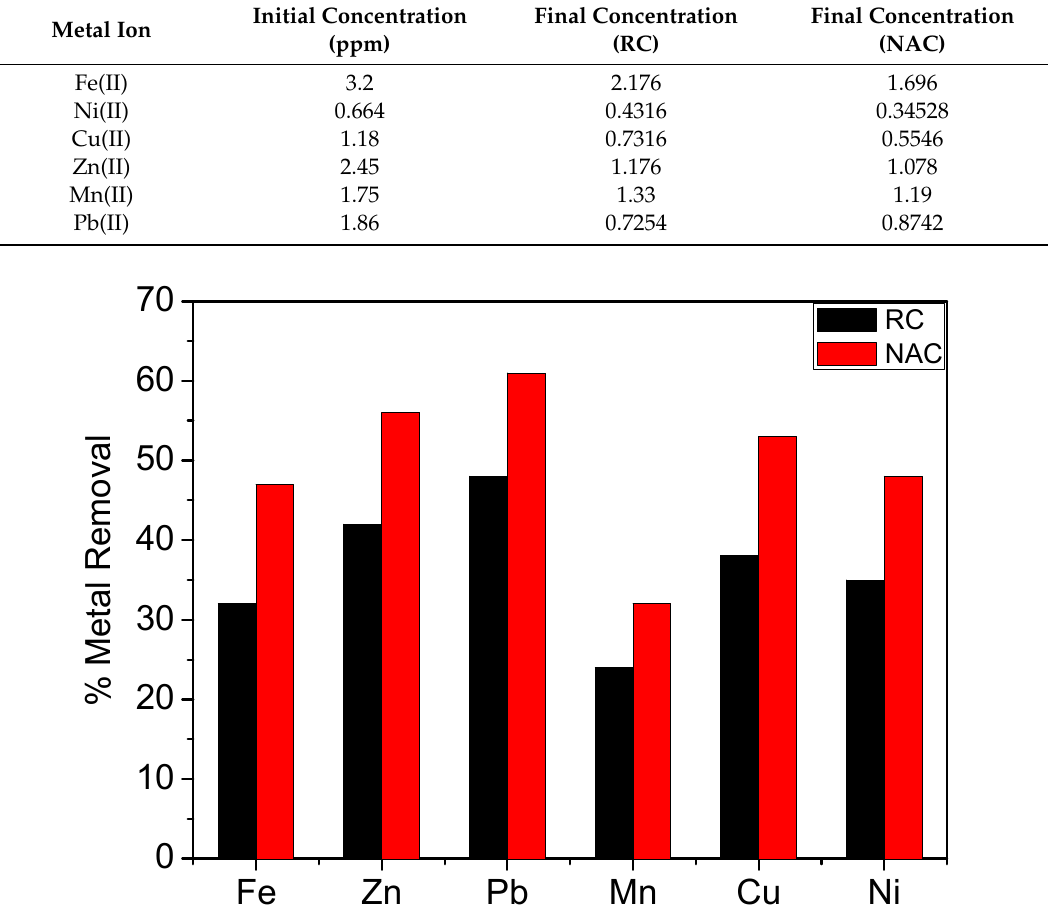
Figure 7. Schematic diagram for heavy metals decontamination from discharged petrochemical wastewater using raw coal and nano-activated carbon (0.2 g/L carbon sample, contact time 2 h, temperature 25 ± 2 °C).